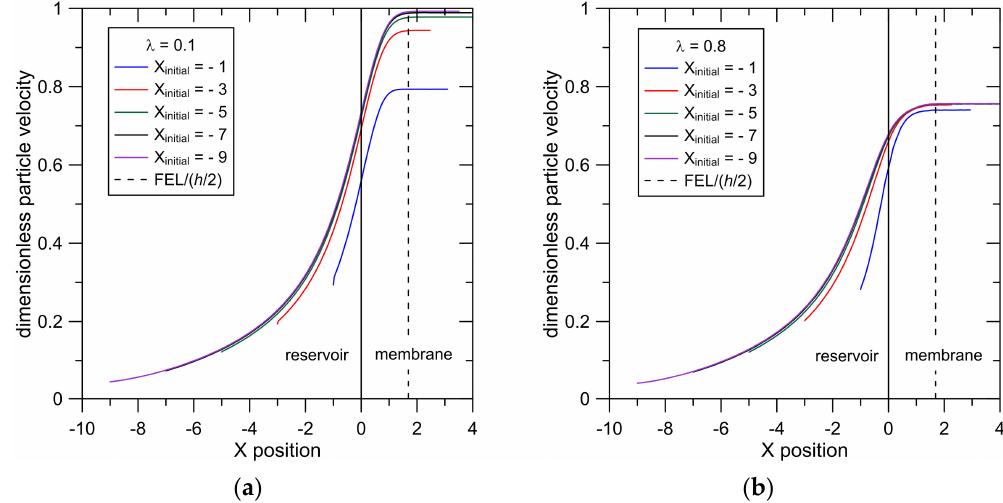
Figure 3. Particle velocity as a function of X for particles moving from the reservoir into the pore for ( a ) λ = 0.1 and ( b ) λ = 0.8; particle specific gravity = 1.1, Y initial = 1 and X initial = − 1, − 3, − 5, − 7 − 9.